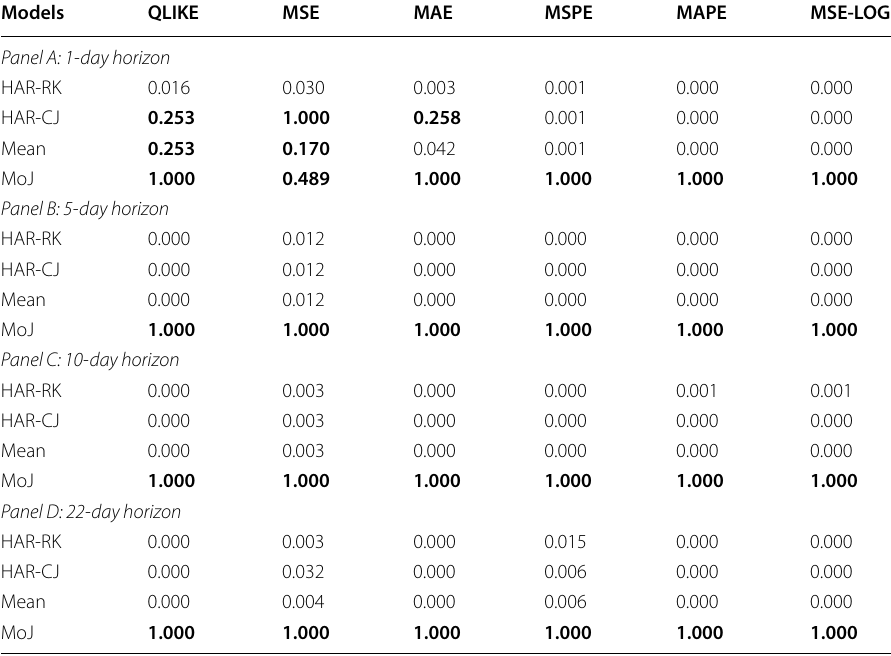
Table 10 MCS out-of-sample forecasting test based the volatility measure of realized